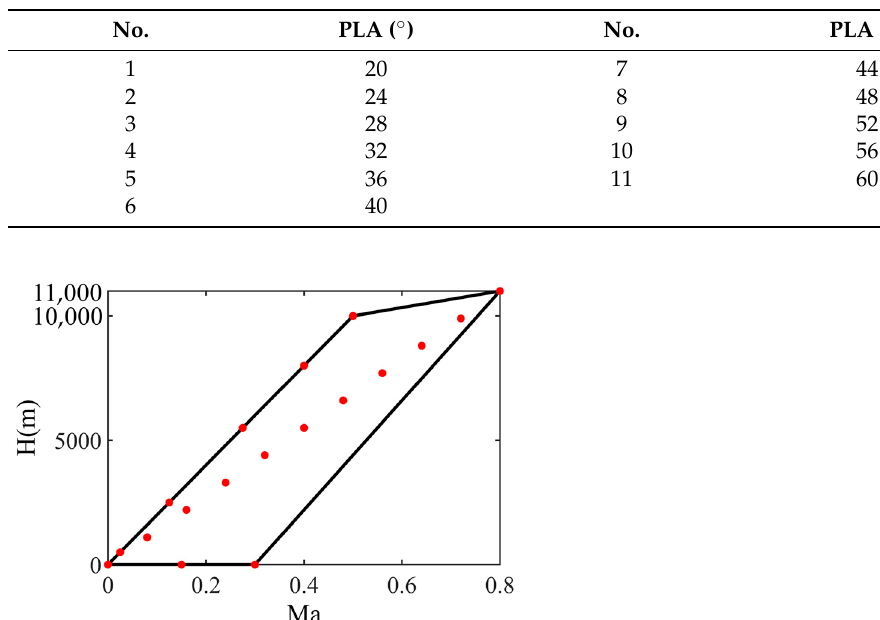
Table 5. Model input u : Command of the PLA.